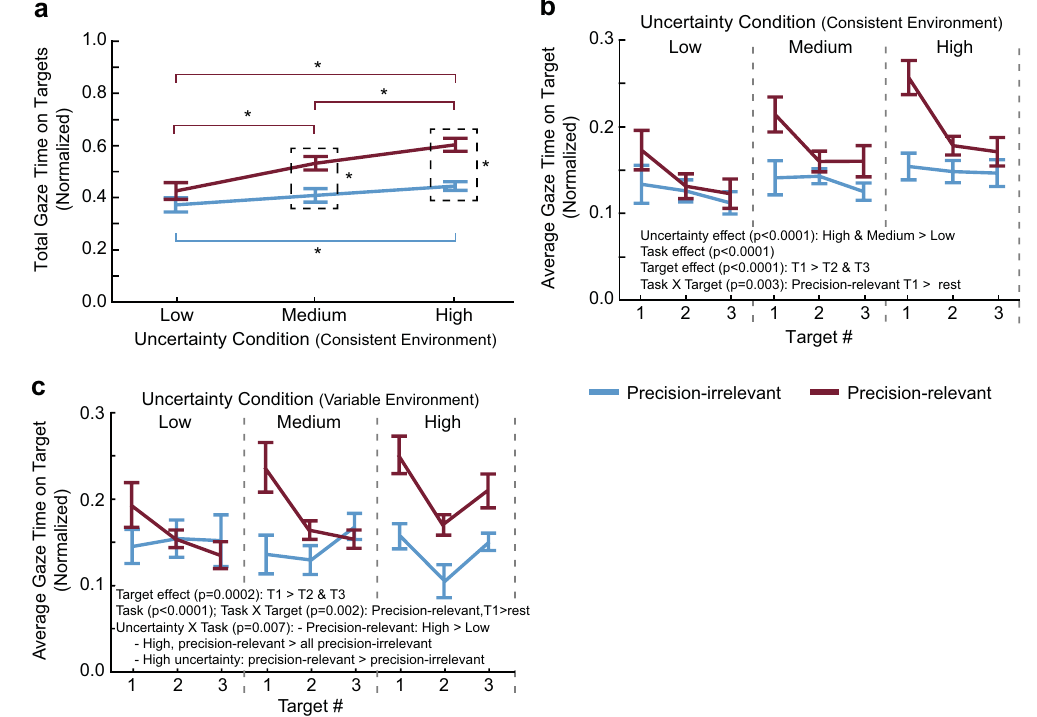
Figure 2. Gaze behaviour. Total gaze time on targets ( a ) and average gaze time on a target ( b ) across uncertainty conditions and tasks in the consistent environment experiment. ( c ) Average gaze time on a target for each uncertainty level and task in the variable environment experiment. Data are represented as mean ± SE. Gaze times are normalized (i.e., divided) by trial duration to control for differences in gait speed between trials and conditions. * Indicates that values are significantly different from each other based on post hoc tests following a significant Task X Uncertainty condition interaction (p <